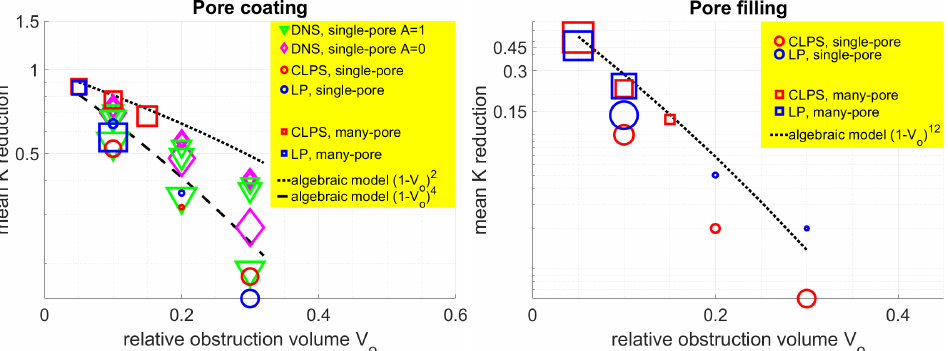
Figure 28. Illustration of sensitivity of mean reduced permeability to the choice of V o and to the choice of initial pore geometry. The displayed results were obtained by DNS in various variants, and reduced models CLPS and LP for pore coating, and CLPS and LP for pore filling. The algebraic models guide the eye. The data are extracted from Tables 6 and 7, and the marker size is proportional to the standard deviation for the data. The illustrations confirm the observations made in text, which we paraphrase here. The reduced model results generally qualitatively agree with DNS and algebraic models from Remark 1, but simulation models predict a more severe reduction in K than predicted by algebraic models. They have larger uncertainty for pore-coating scenarios and pore-filling scenarios for small V o . Predictions for single-pore and many-pore geometries are similar to each other for small V o , but their mean is not reliable at large V o due to clogging, especially for many-pore